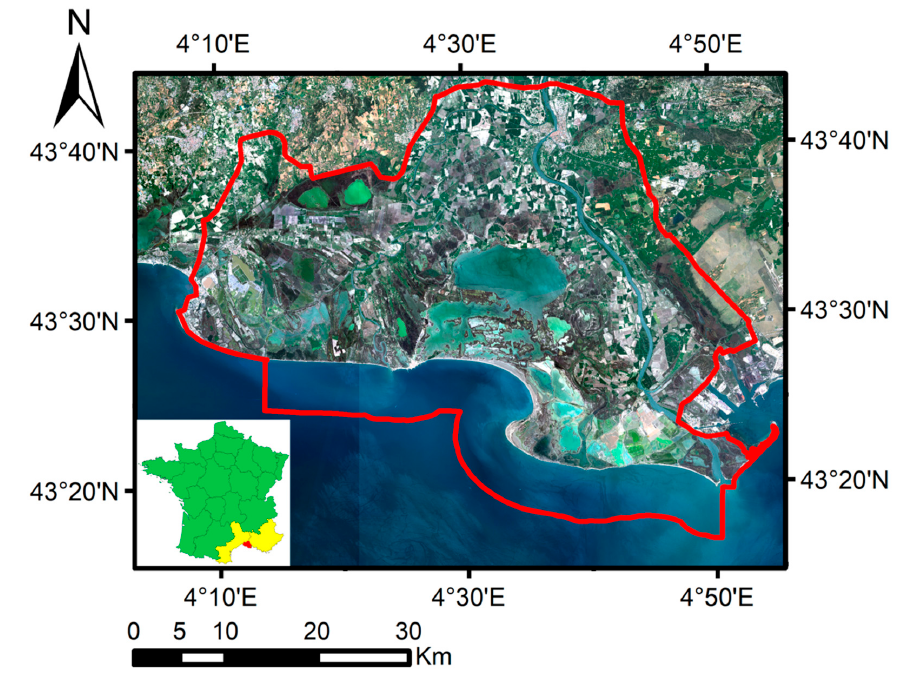
Figure 1. Map of the Camargue Biosphere Reserve located in south France, partially falling within the Occitanie and Provence-Alpes-Côte d’Azur administrative regions, with underlying S2 RGB (red-green-blue) image on 18 April 2018. Red line: boundary of the Biosphere Reserve.